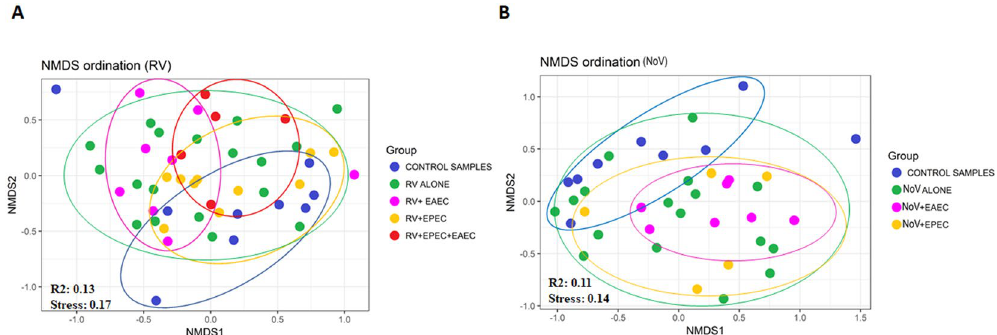
Figure 2. Nonmetric multidimensional scaling (NMDS) ordination of fecal microbiota in AGE infected patients. The Bray-Curtis index were performed between all infected children and controls to generate NMDS to visualize gut microbiome similarities. Each dot in the figure denotes microbiota profile of a single patient in a low-dimensional space. Colored dots denotes groups of patient’s microbiome. The subject’s cluster together depending upon their microbiome profiles. ( A ) NMDS ordination of microbiomes in control samples, RV- alone, RV + EAEC, RV + EPEC, and RV + EPEC + EAEC. ( B ) NMDS ordination of microbiomes in control samples, NV-alone, NV + EAEC, and NV +